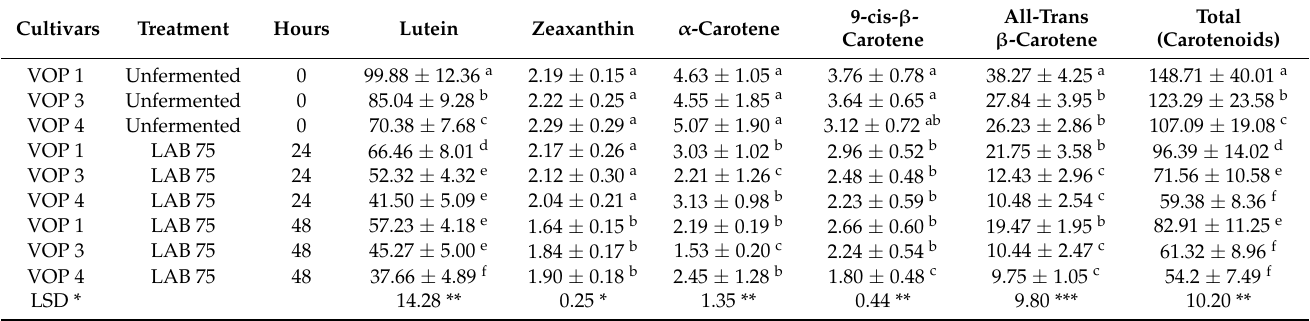
Table 5. The carotenoid profile of Ltp. plantarum 75 fermented and unfermented cowpea leaf smoothies from different cultivars (mg/100